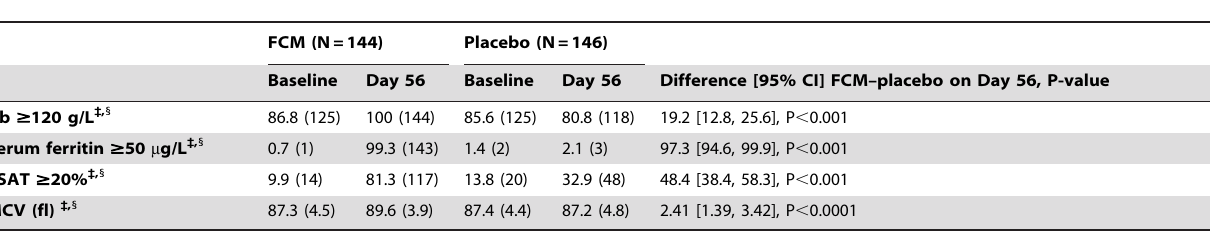
Table 4. Secondary endpoints – Hematologic parameters (% [n] or mean [SD])